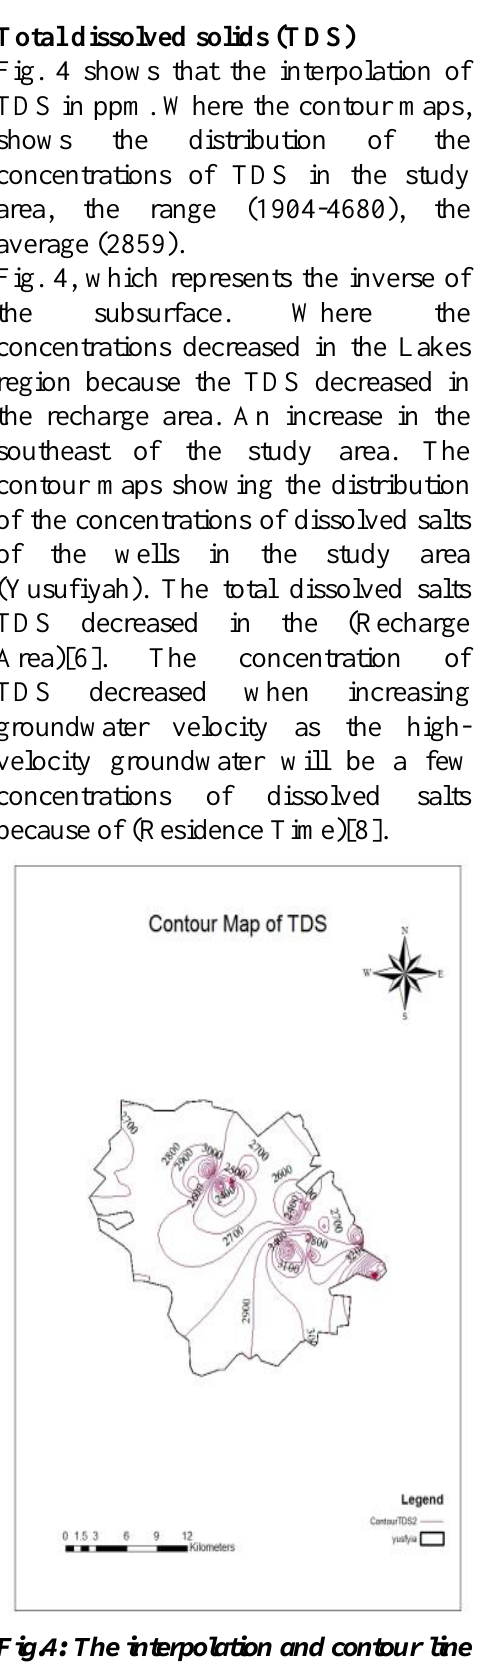
Fig.5: The interpolation and contour line of Ca map in